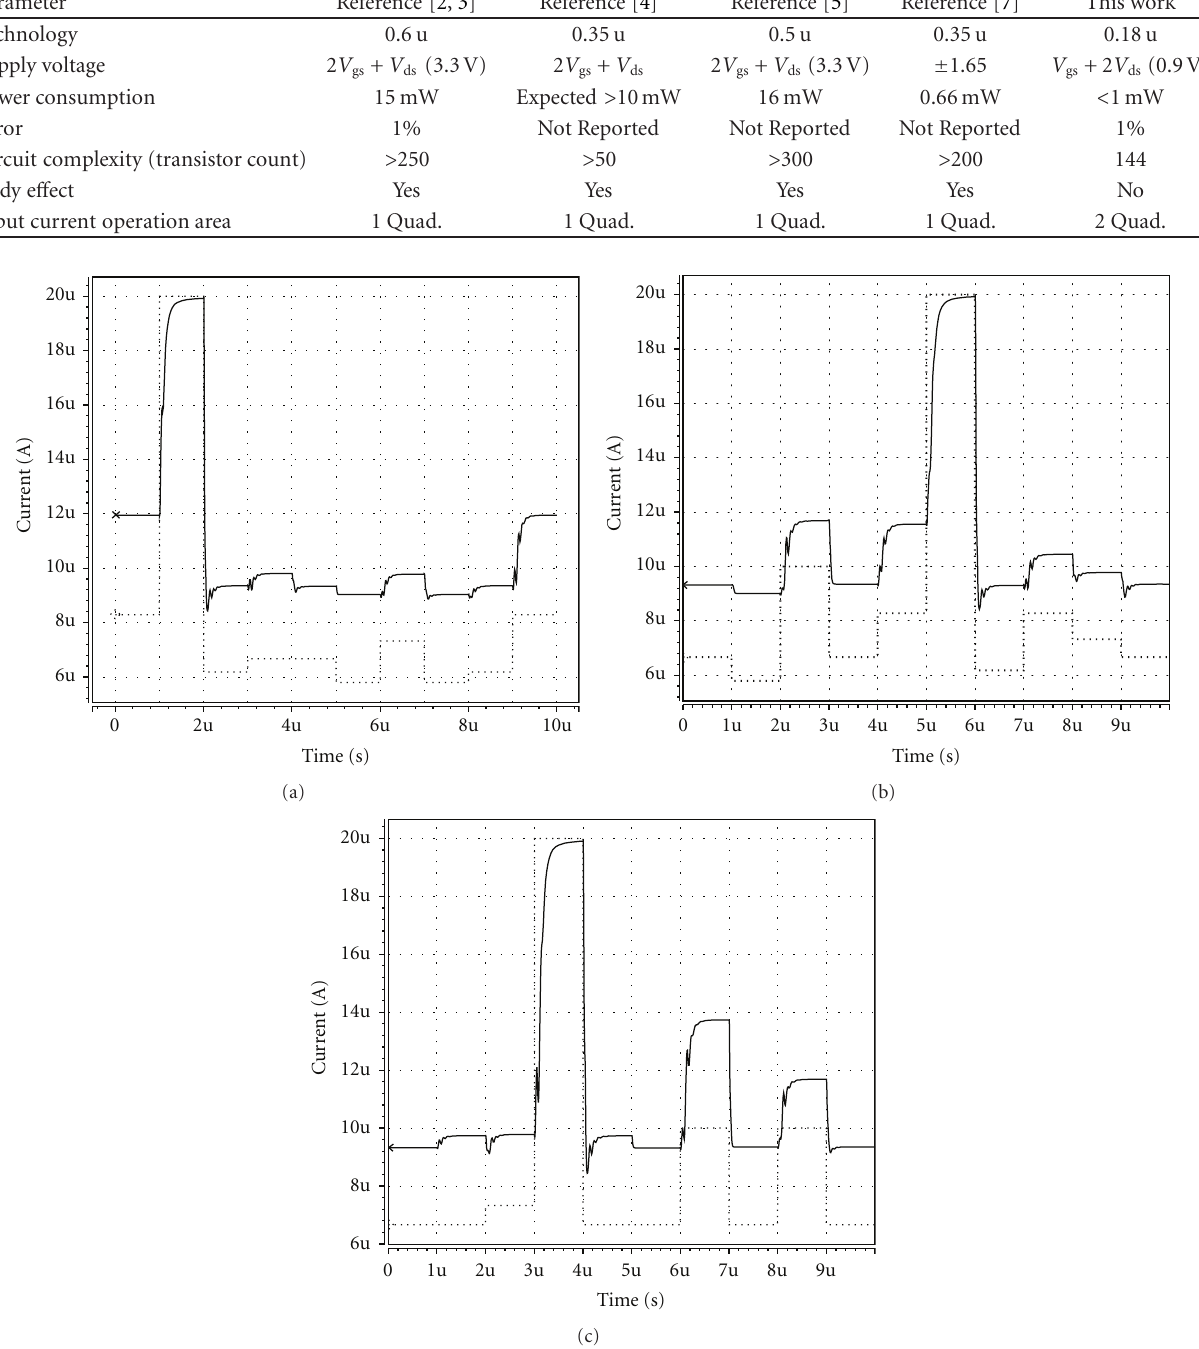
Figure 8: Time response of the membership degree calculator circuit for input patterns of (a) U 1, (b) U 2, and (c) U 3